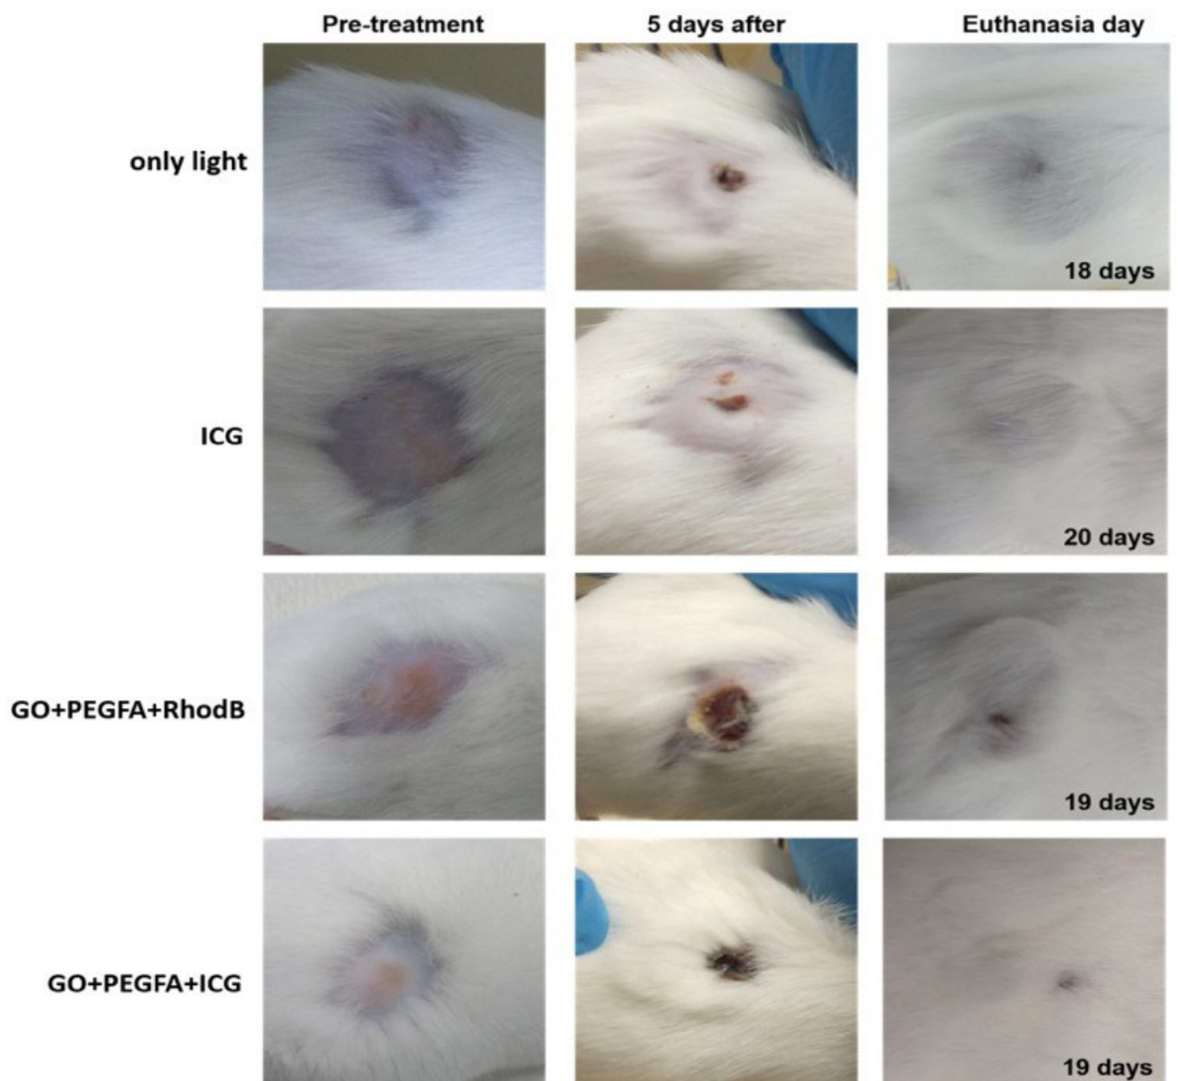
Figure 16. Representative mice images showing the sizes of tumors at pre-treatment day, 5th day, and euthanasia day under 808 nm, 1.8 W/cm 2 for light, ICG, GO+PEGFA+RhodB, and GO+PEGFA+ICG mice groups. Reproduced from Ref. [72] with permission from PMC.